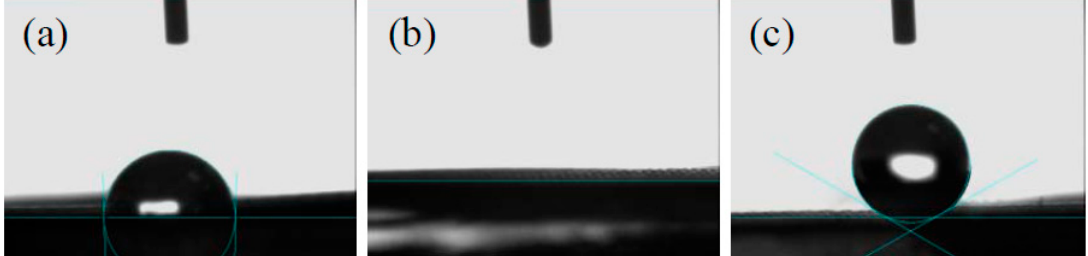
Figure 6. Contact angle of water on ( a ) the clean stainless steel mesh surface (91.3°), ( b ) the superhydrophilic membrane (0°), ( c ) contact angle of oil on the superhydrophilic membrane under water (158°).